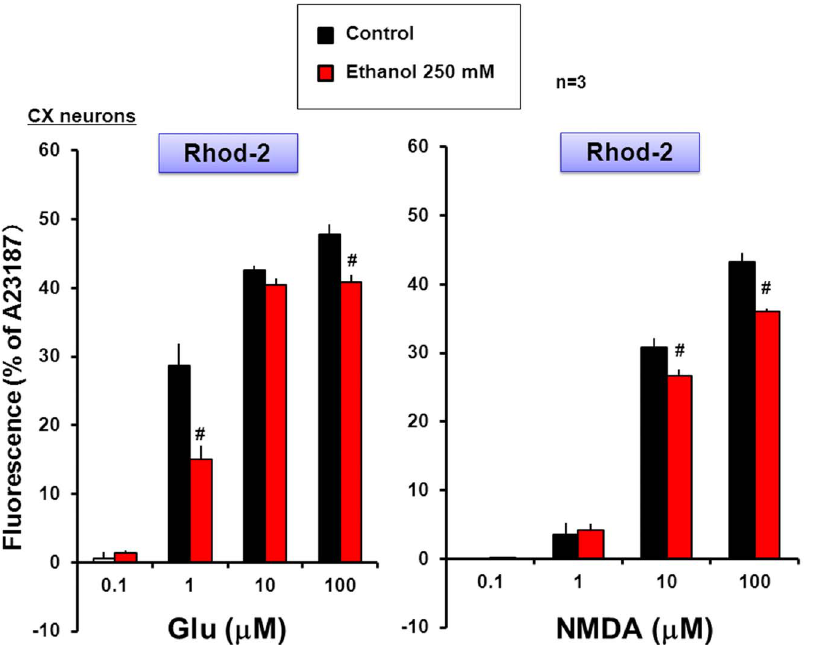
Figure 1. Effects of ethanol on Rhod-2 fluorescence in cultured neurons. Murine neocortical neurons were cultured for 8 days, followed by loading of Rhod-2 and subsequent cumulative exposure to Glu or NMDA at different concentrations in either the presence or absence of 250 mM ethanol. Values are percentages over the maximal fluorescence by A23187 in 3 independent determinations. # P , 0.05, significantly different from each control value obtained in cells not exposed to ethanol. Statistical significance was determined according to the Students’ t -testanalysis.